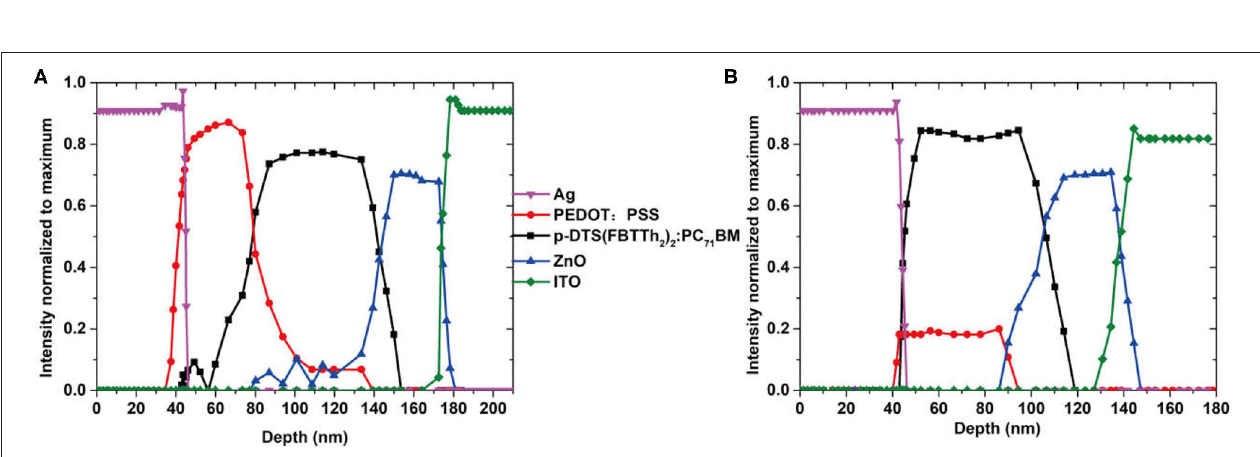
FIGURE 3 | ToF-SIMS measurements on the (A) glove-box-processed and (B) air-processed organic solar cell. Ag (CsAg + ) was detected in the positive polarity spectrum.